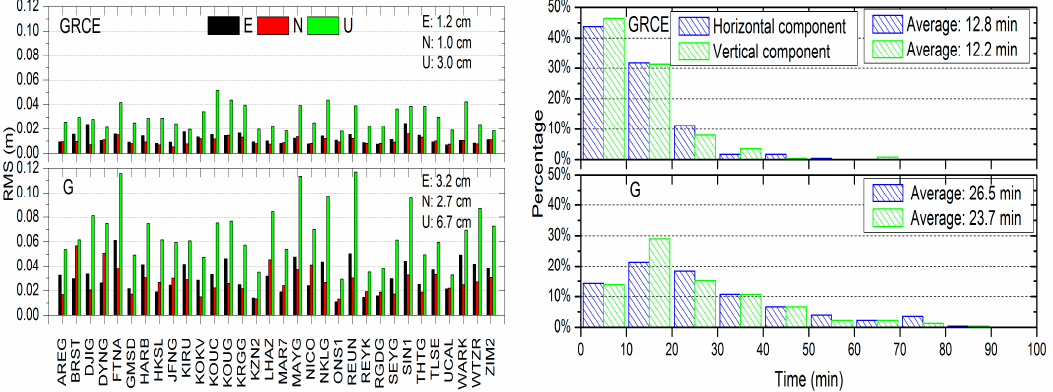
Figure 9. The positioning RMS of the GRCE combined PPP and the GPS PPP in east, north, and upward coordinate components ( left ), and the convergence time statistic in the horizontal and vertical components ( right ).